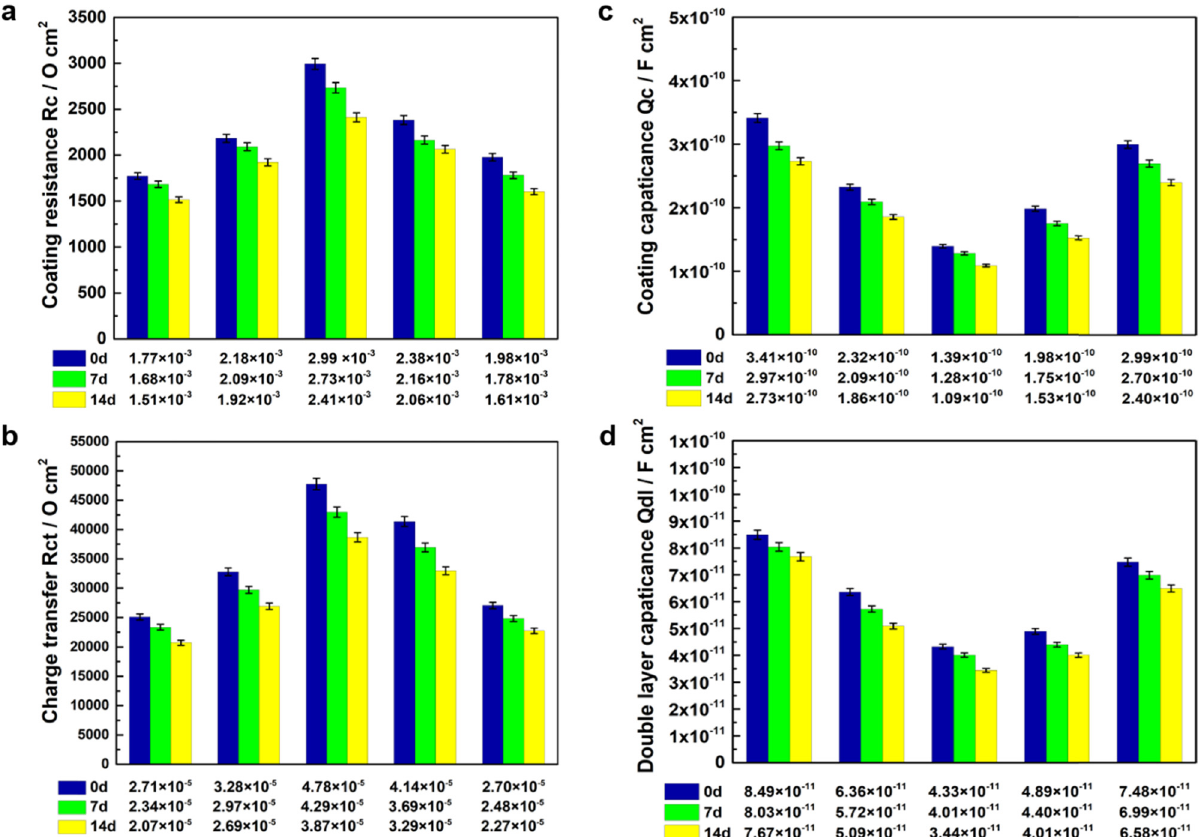
Figure 10: Electrical parameters ( a ) R c , ( b ) R ct , ( c ) Q c , and ( d ) Q dl of composite coatings after 0, 7, 14 days of immersion in 3.5% NaCl ( aq ) . From left to right, 0% ZIF - 67@EP coating, 0.5% ZIF - 67@EP coating, 1% ZIF - 67@EP coating, 2% ZIF - 67@EP coating, and 3% ZIF - 67@EP coating,